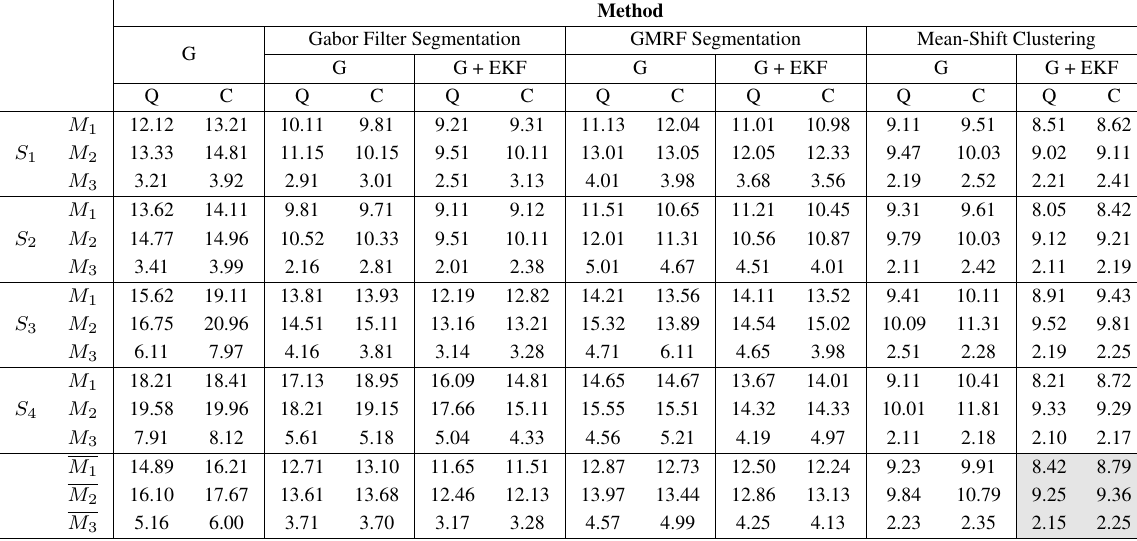
Table 3. Lane detection and tracking results.